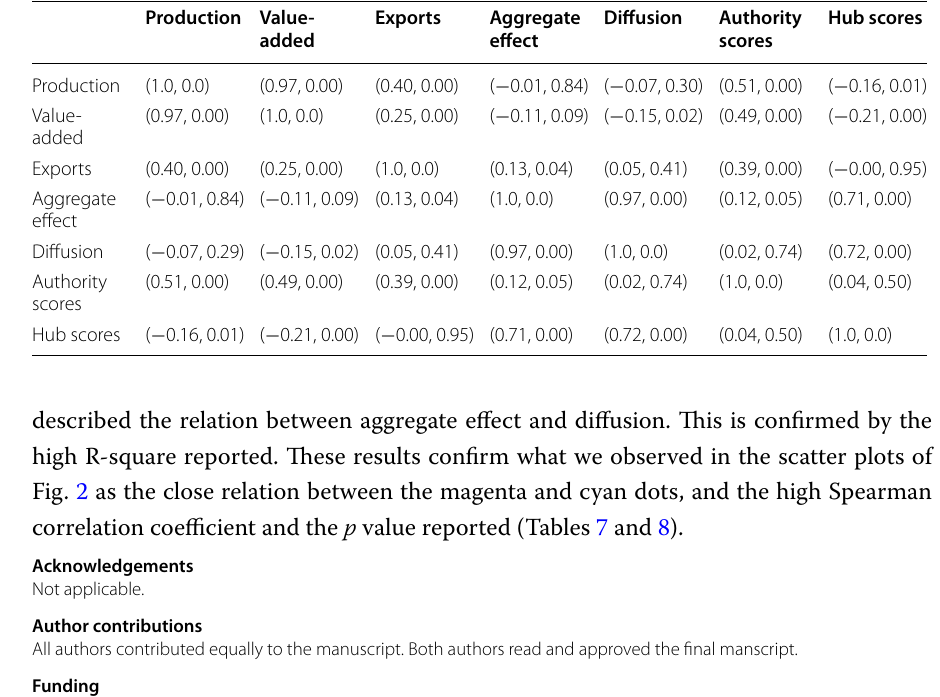
Table 8 Spearman correlation coefficients matrix (rho, p value) 2012. Source: made by authors based on authors calculations using Python 3.8 and Python